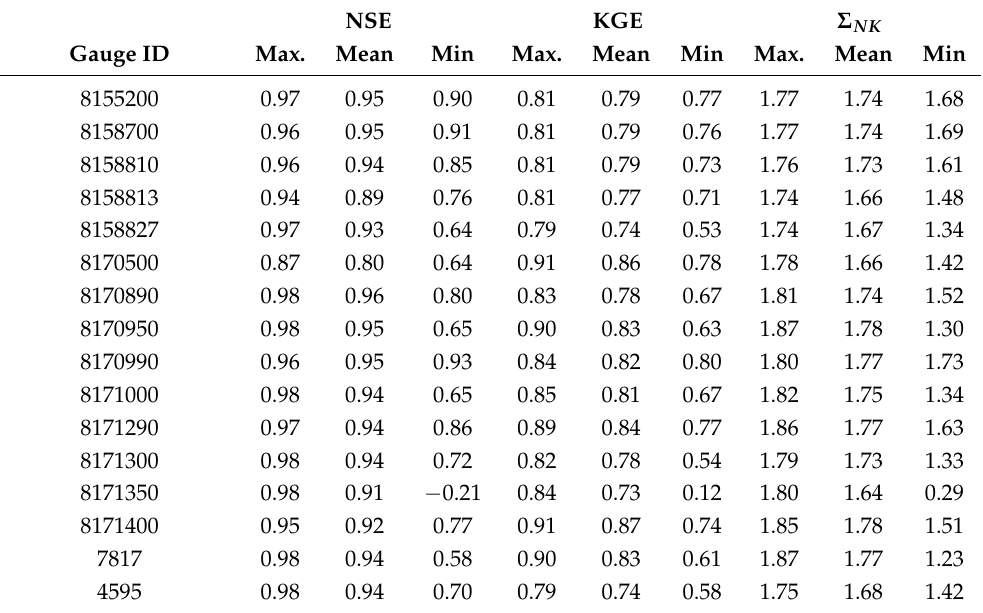
Table 5. Monthly ‘goodness-of-fit metrics’ between gauge discharge and synthetic, unbiased dis- charge time series. NSE KGE Σ NK Gauge ID Max. Mean Min Max. Mean Min Max. Mean Min 8155200 0.97